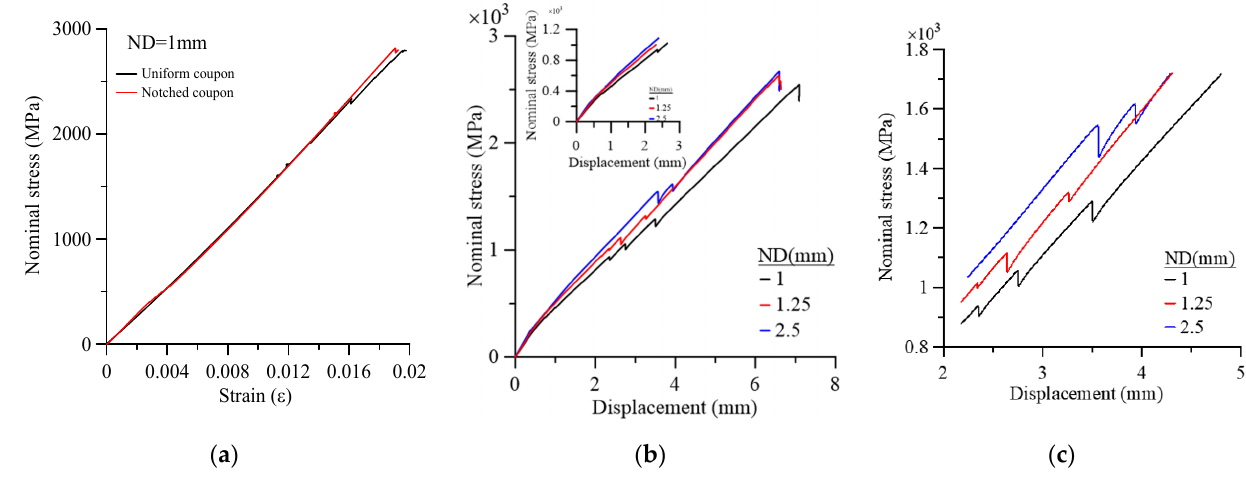
Figure 16. Nominal stress vs. strain and displacement for various notched coupons; ( a ) stress vs. strain for ND = 1 mm; ( b ) stress vs. displacement curves up to fracture; ( c ) extended zone where load relaxations were detected.